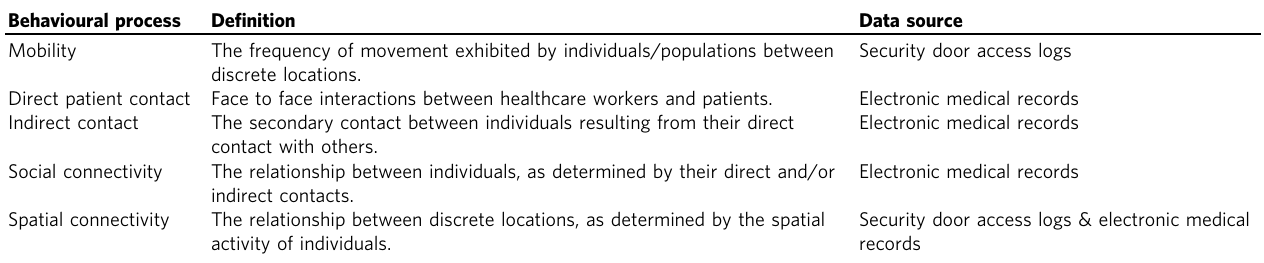
Table 1 De fi nitions and data sources for behavioural processes relating to healthcare worker activity in the healthcare